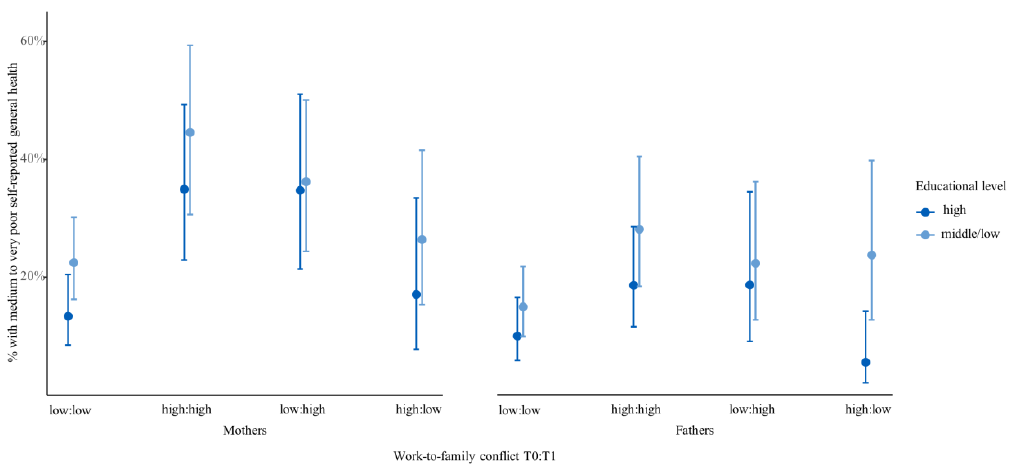
Figure 3. Predictive margins for parents with satisfying-to-bad self-reported general health (T1) by WTFC (T0 and T1) and educational level, adjusted for age, region, and self-reported health T0, n = 791 mothers and n = 723 fathers (in % and 95% CI).